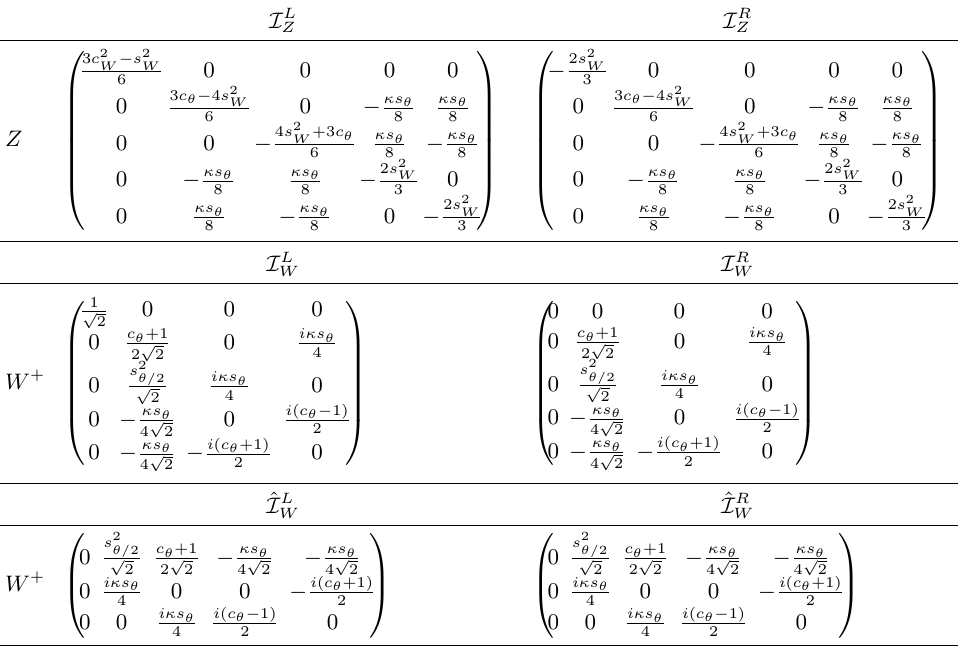
Table 8 . The expressions for the couplings to the Z and W bosons, I L,R